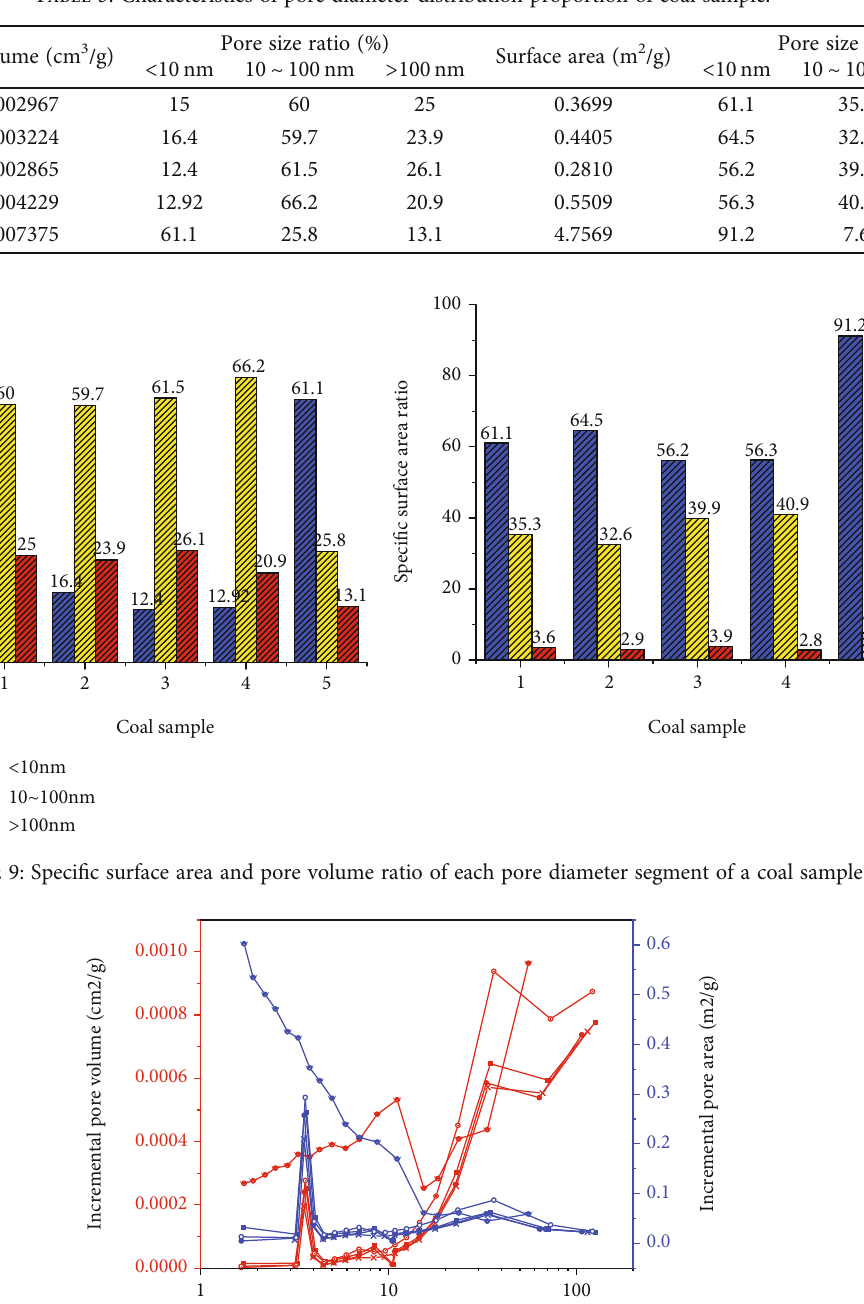
Table 3: Characteristics of pore diameter distribution proportion of coal sample.